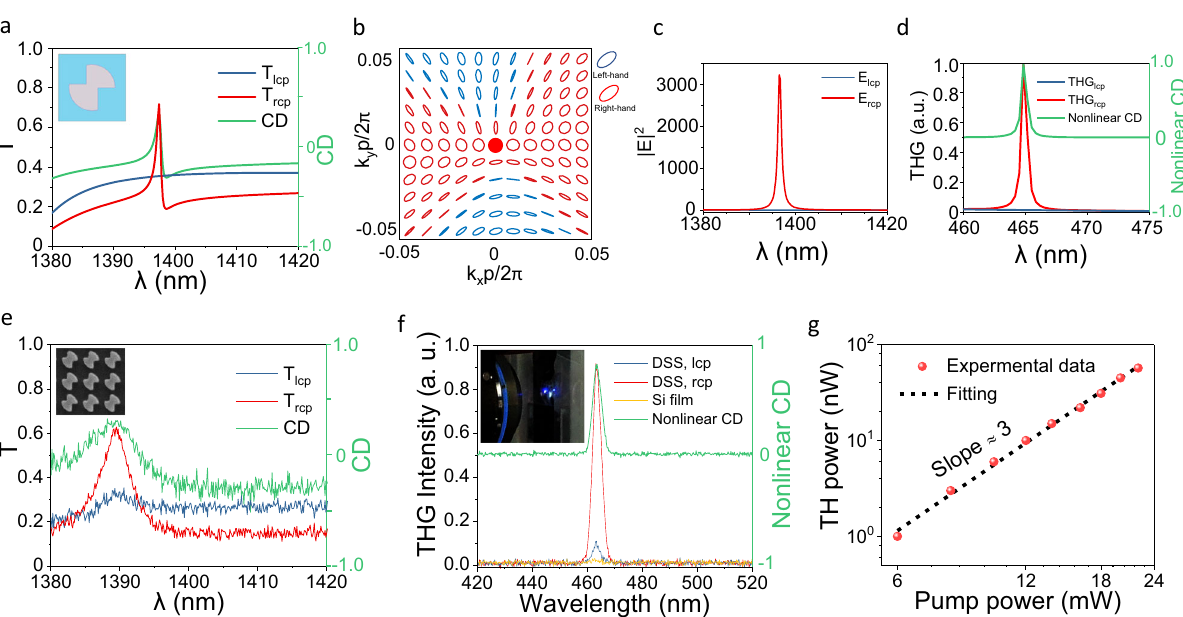
Fig. 5 Near-unity nonlinear CD with planar chiral q-BIC metasurface. a Simulated transmission spectra of T lcp and T rcp as well as the linear CD spectra of the metasurface with parameters P = 780nm, R = 268nm, L 1 = 197nm, L 2 = 200nm, W 1 = 217nm, W 2 = 257nm, and H = 654nm with an asymmetric structure parameter( δ = 40nm) fornormalincidences.InsetsshowtheStructurediagram. b Theeigen-polarizationpro fi leinthe k -space.Thereddotrepresentsthecircular eigen-polarization ( C point). c Contrast of electric fi eld enhancement | E | 2 of different circularly polarized light. d Simulated THG intensity under different circularly polarized light incidence and the corresponding nonlinear CD. The nonlinear CD is de fi ned as the normalized THG difference between RCP and LCP lights. e Measured transmission spectra of T lcp and T rcp as well as the linear CD spectrum. Insets show the SEM image of the metasurface sample. f Experimentally measured THG intensities under RCP, LCP incidences in planar chiral q-BIC metasurface, THG intensity in a reference Silicon thin fi lm, as well as the measured nonlinear CD spectra. The inset shows a photographic image of the light spot of THG from the sample. g Power dependence of THG in logarithmic scale showing cubic power scaling law. The red dots show the measured data, the black dashed line is a fi t to the data with a third-order power